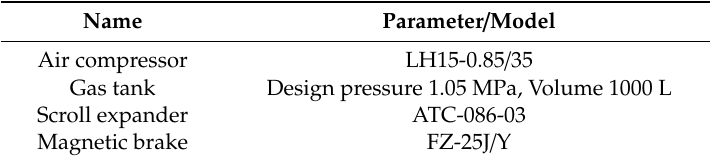
Table 2. The main equipment parameters.